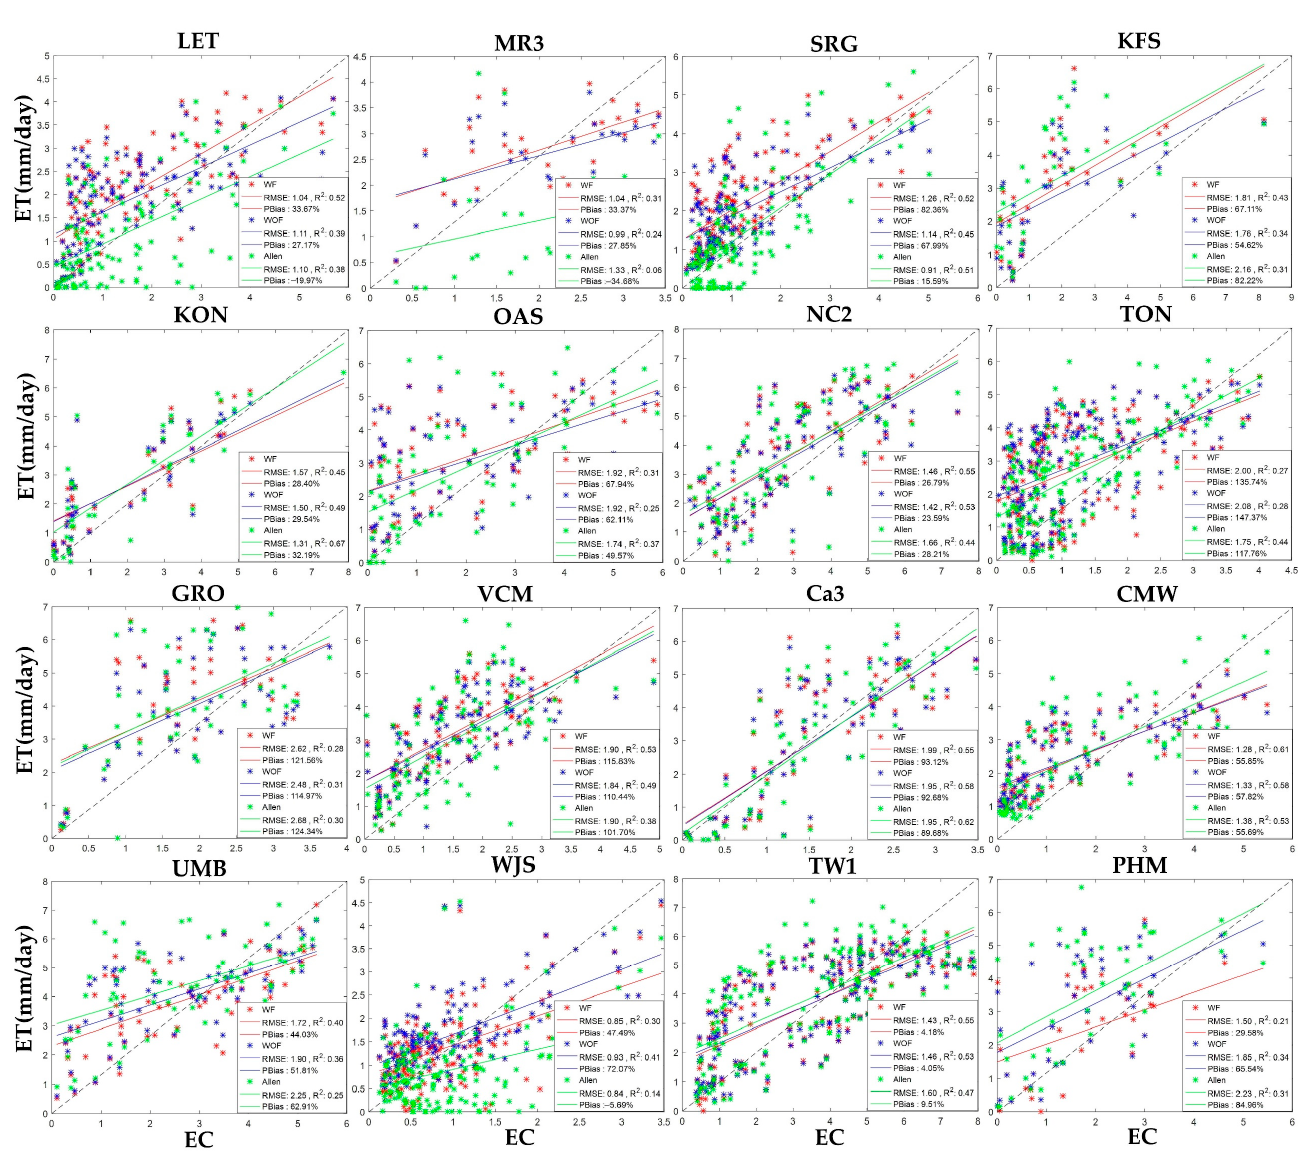
Figure A2. Daily actual ET estimated by the endmember selection models and using the GLDAS datasets vs. EC for the different crop flux tower sites.